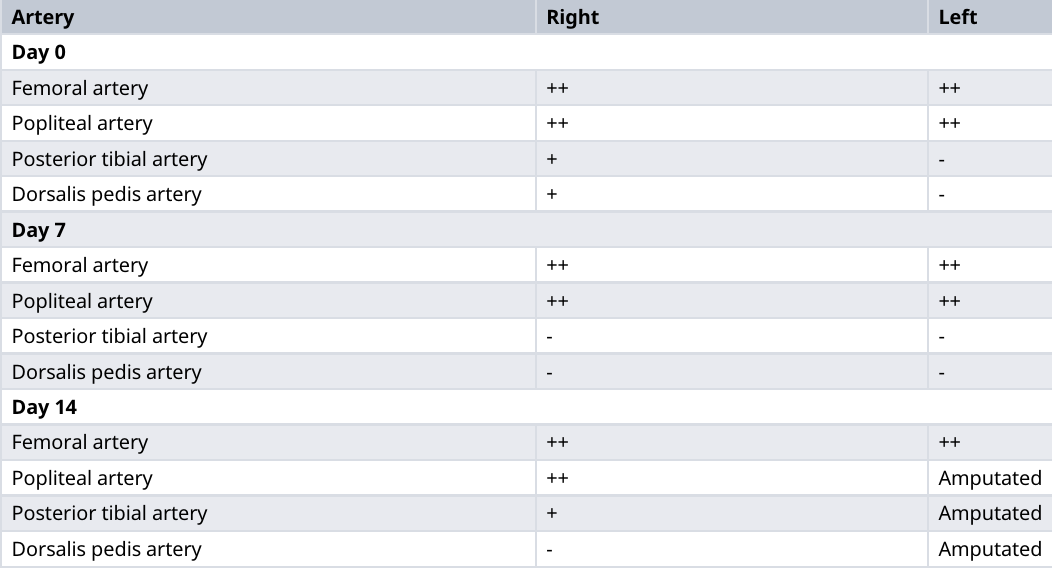
Table 1. The pulsation status of the patient. Artery Right Left Day 0 Femoral artery ++ ++ Popliteal artery ++ ++ Posterior tibial artery + - Dorsalis pedis artery + - Day 7 Femoral artery ++ ++ Popliteal artery ++ ++ Posterior tibial artery - - Dorsalis pedis artery - - Day 14 Femoral artery ++ ++ Popliteal artery ++ Amputated Posterior tibial artery + Amputated Dorsalis pedis artery -